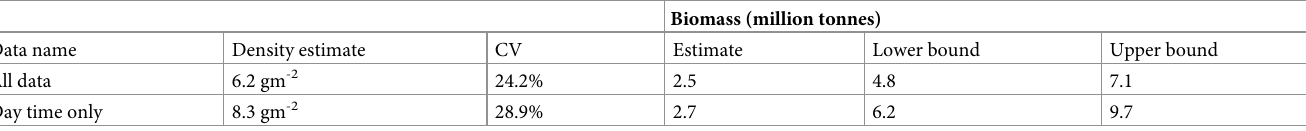
Table 3. Krill biomass estimate for the eastern sector of the CCAMLR Division